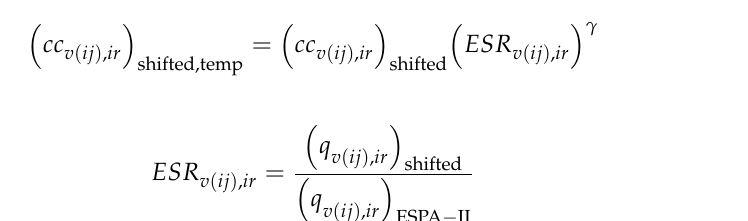
Figure 3. By adopting the stability measure, the target deviations for cases in three types of numerical experiments were as shown above: ( a , b ) contains cases for the first type without and with maximum area limitations; ( c , d ) contains cases for the second type without and with maximum area limitations; ( e , f ) contains cases for the third type without and with maximum area limitations.